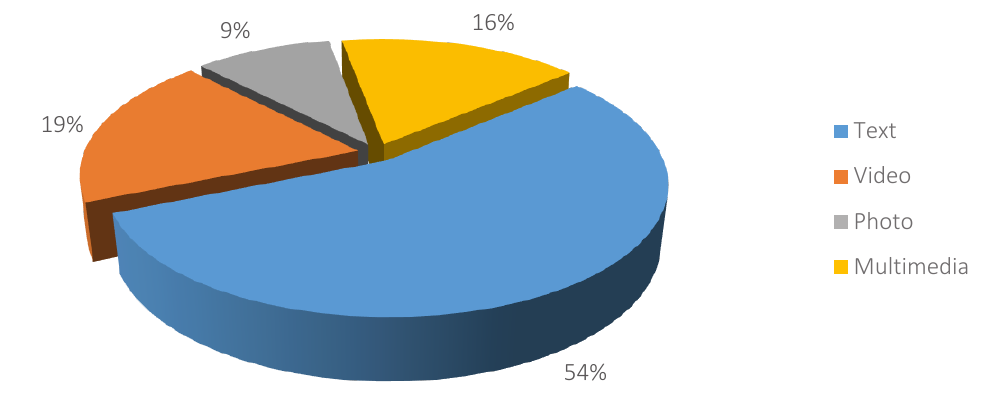
Figure 4. News formats that are most convenient for respondents